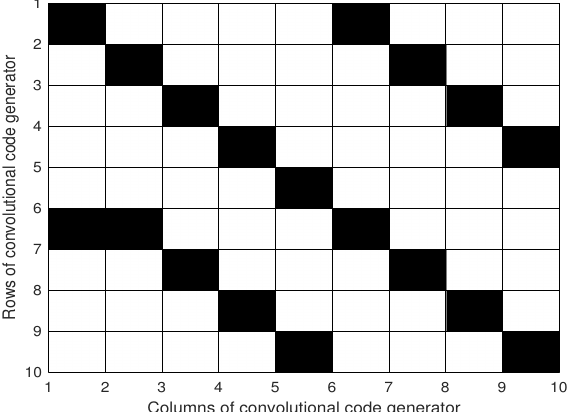
Figure 3. The { + 1,0 } distribution of the convolutional code generator, where black block denotes +